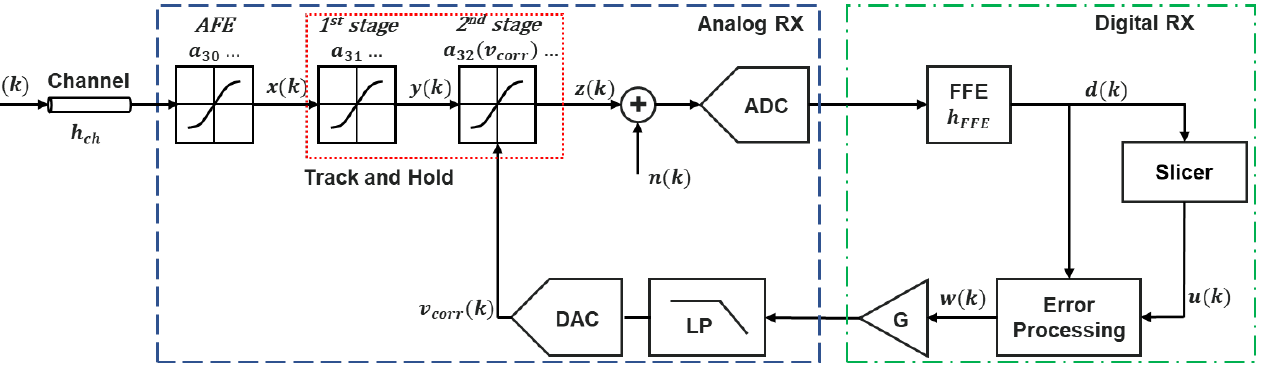
Figure 6. Block diagram of the receiver and of the proposed feedback loop to maximize linearity.